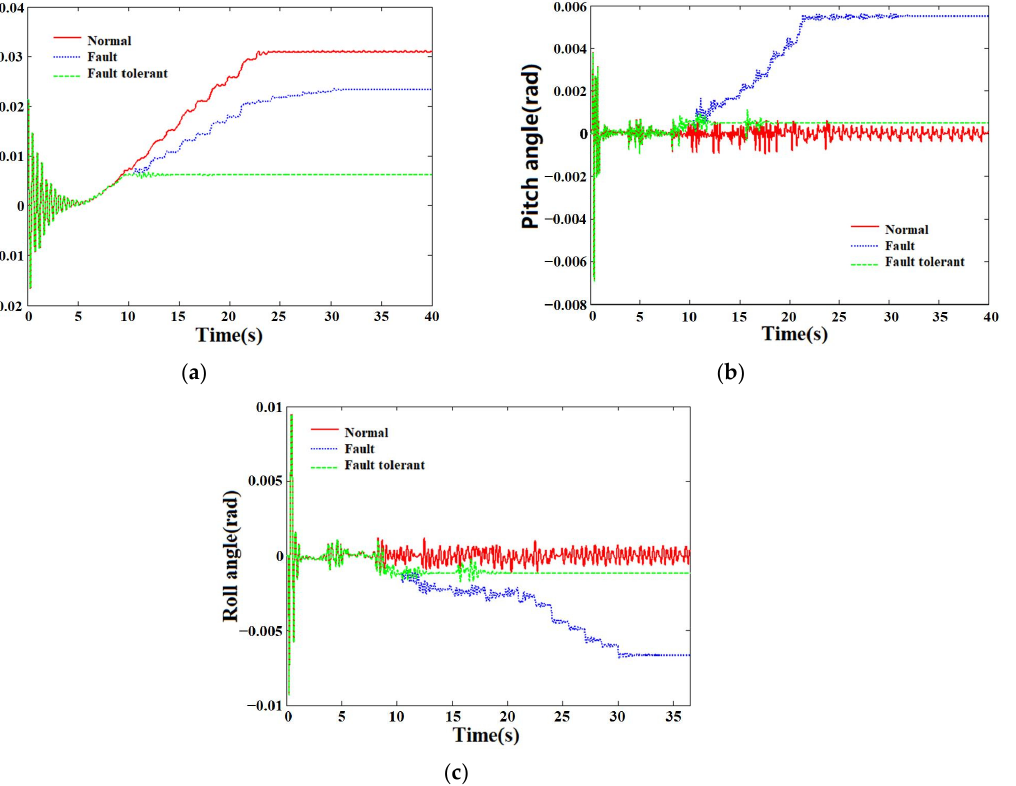
Figure 9. Performance comparison before and after fault tolerant control under Fault 1 (stuck): ( a ) Relative height of mass center; ( b ) Pitch angle; ( c ) Roll angle.